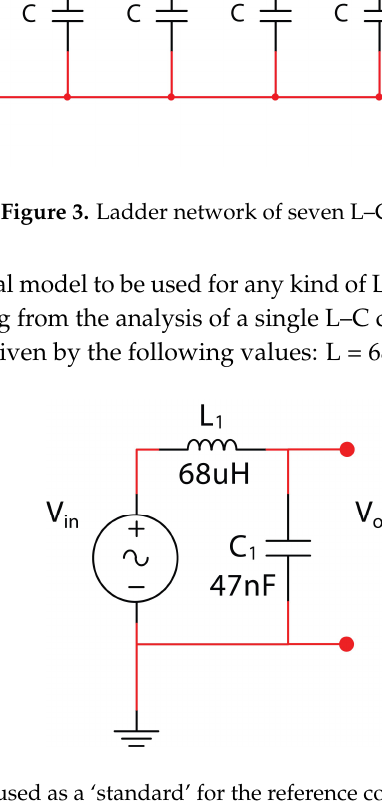
Figure 5. Magnitude vs frequency plot of the single-cell L.N. reported in Figure 3 showing the behavior of a low pass filter.